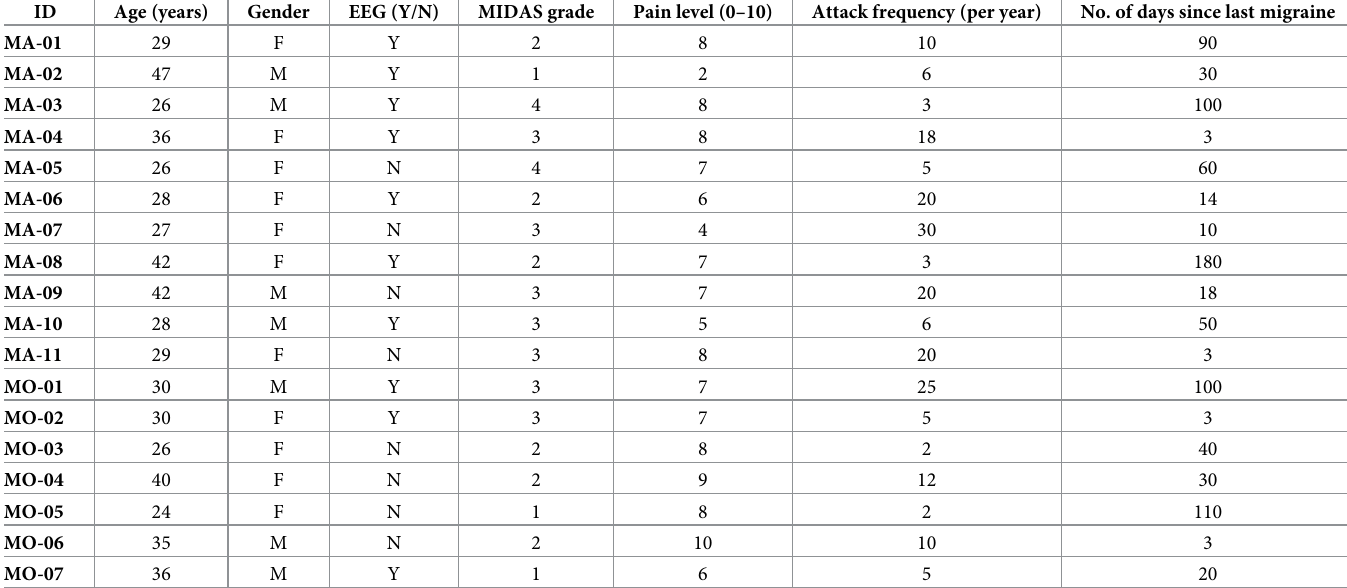
Table 1. Participant demographics including aura (with:MA; without:MO), age in years, gender (M:Male, F:Female), participation in the electrophysiology (EEG) study (Y:Yes, N:No) and Migraine Disability Assessment Severity (MIDAS) questionnaire data collected from the migraine